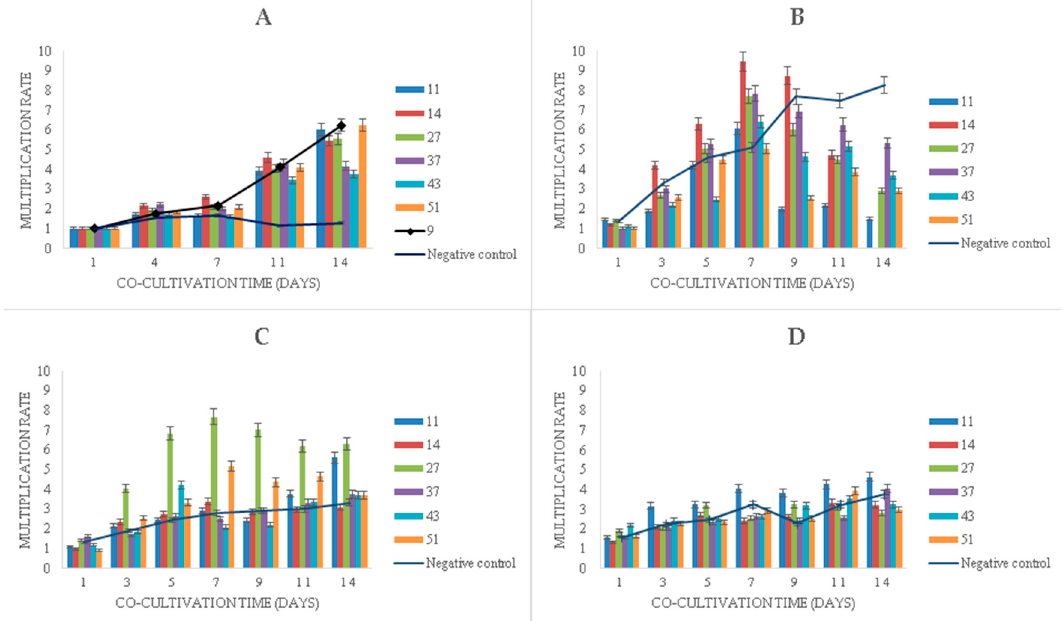
Figure 5. Multiplication rates of duckweed in MS medium: ( A ) without phenol; ( B ) with 500 mg L − 1 of phenol, ( C ) with 750 mg L − 1 of phenol, ( D ) with 1000 mg L − 1 of phenol. Numbers in the legend represent bacterial strains used in the experiment: 9— K. oxytoca , 11— Lelliottia sp., 14— K. oxytoca , 27— S. marcescens , 37— H. alvei , 43— H. paralvei , 51— S. nematodiphila . Negative control sample was represented by the duckweeds grown in sterile conditions (bacteria-free). Data represent the mean ± SE ( n = 3).